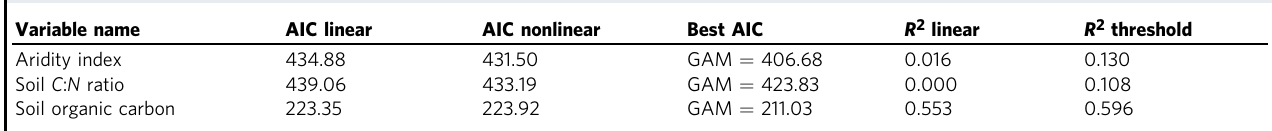
Akaike information criteria (AIC) were used to compare the fi ts of linear, nonlinear, and optimal threshold models. Models with lower AIC values have the best fi ts. Determination coef fi cients ( R 2 ) of linear and best- fi t threshold models are shown. GAM general additive